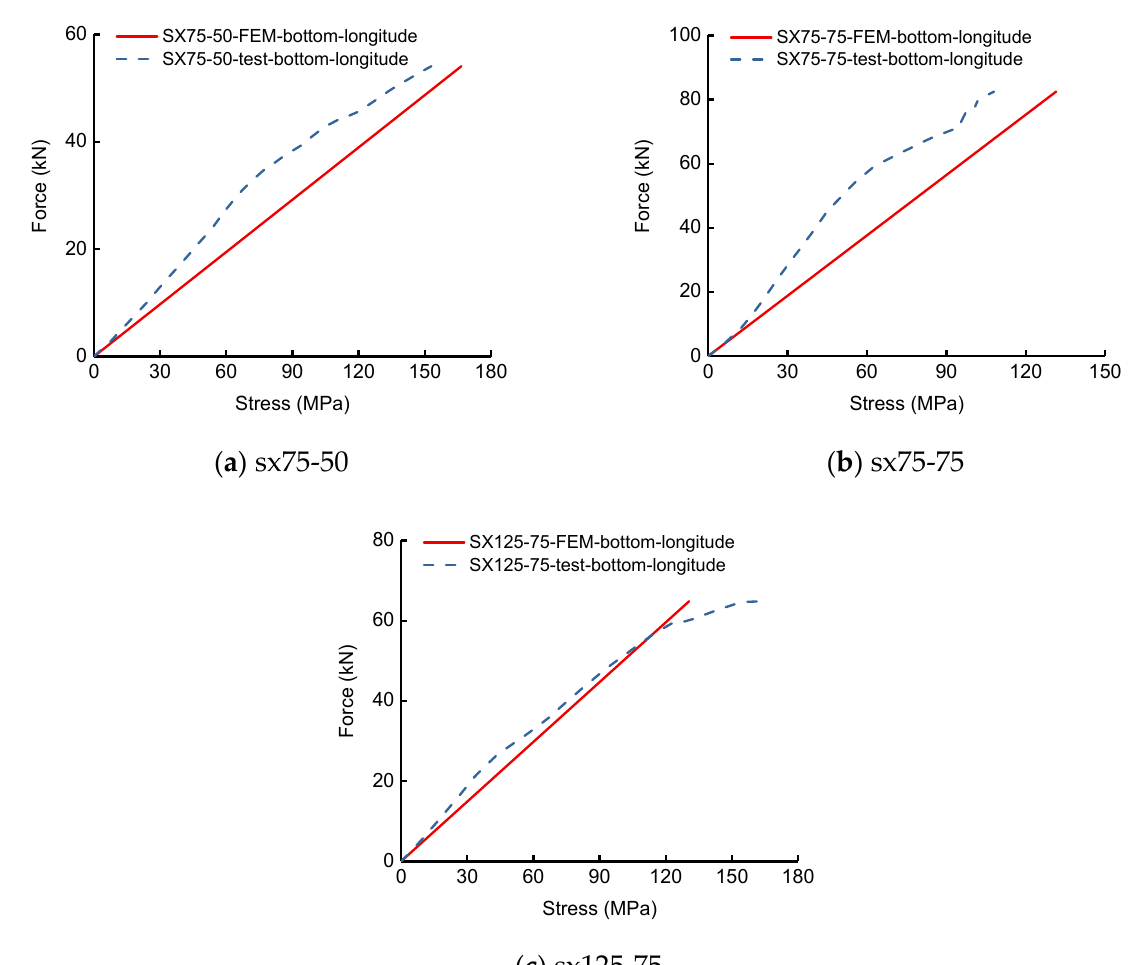
Figure 7. Load-stress curves on the bottom surface of two-way simply supported SLCPs. Table 3. The mid deflection and normal stress under the ultimate bearing capacity. In accordance with Table 3, the bottom deflection errors between the test and FEM for two-way simply supported SLCPs were within 52–61%. The bottom surface normal stress errors were within 8–22%. However, Figure 6 presents that the test load-deflection curves were evidently elastoplastic. During the elastic stage, the FEM load-deflection curves including the top, mid surface, and bottom were very close to the tests’. Figure 7 presents that the test load-stress curves were weak nonlinear until the ultimate stage. Dur- ing the whole loading history, the FEM bottom stress curves became close to the tests’.